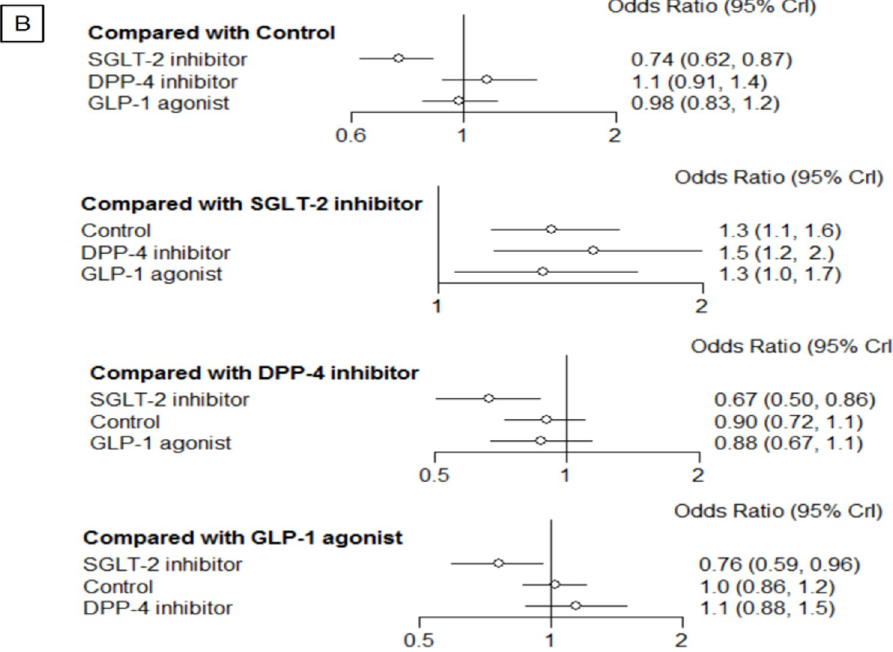
Fig 4. Forest plot for acute kidney injury events (61 trials, 2002 events, 167,584 patients, I 2 = 15%).